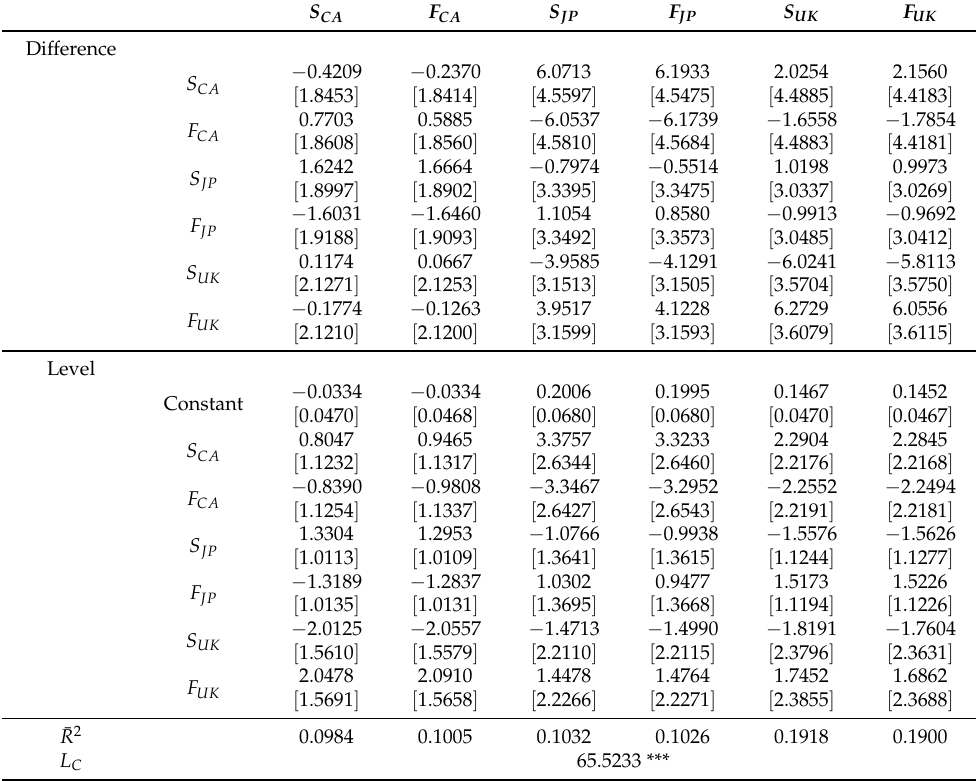
Table 3. Time-Invariant VEC Model